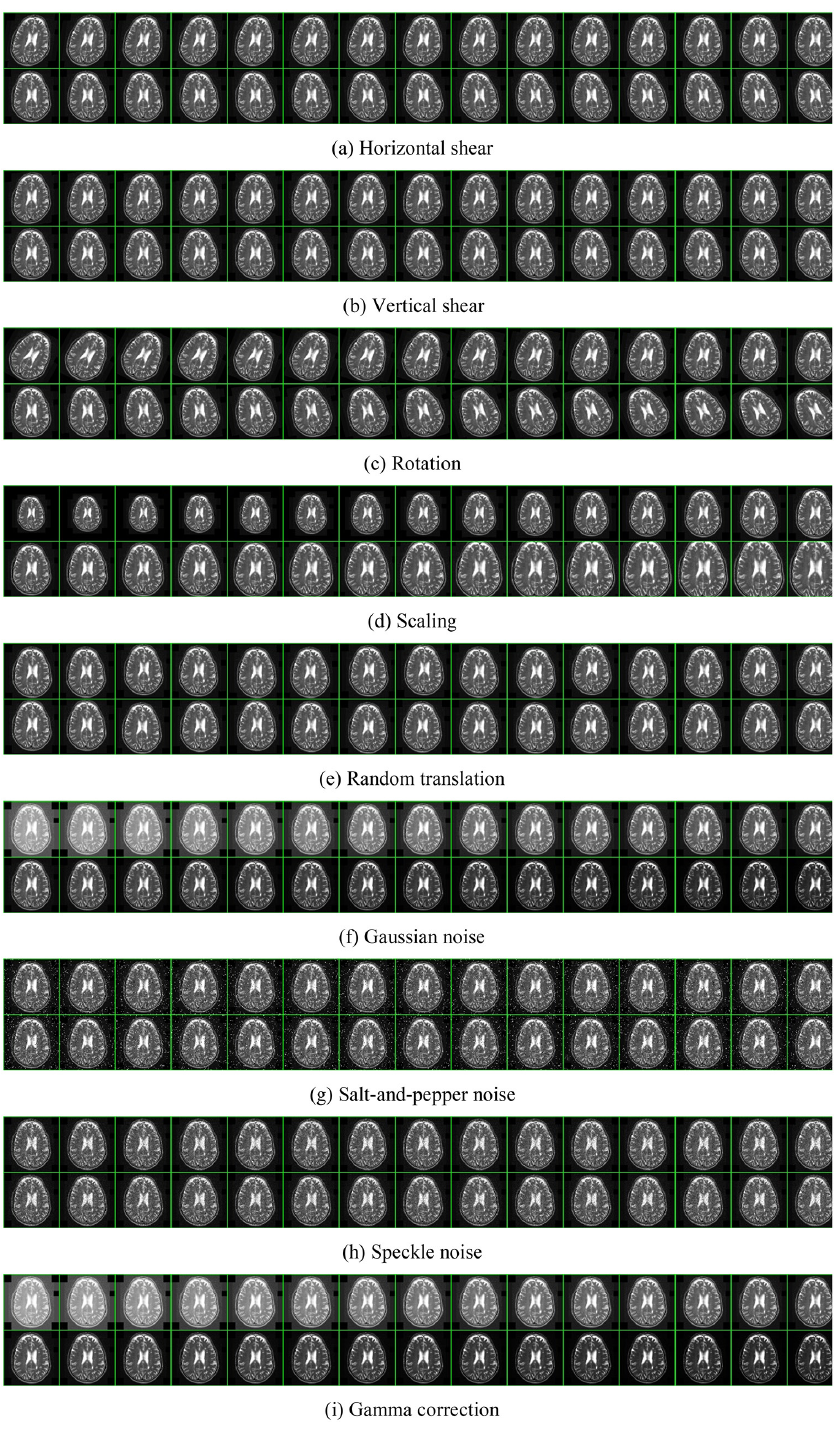
Figure 4. Data augmentation